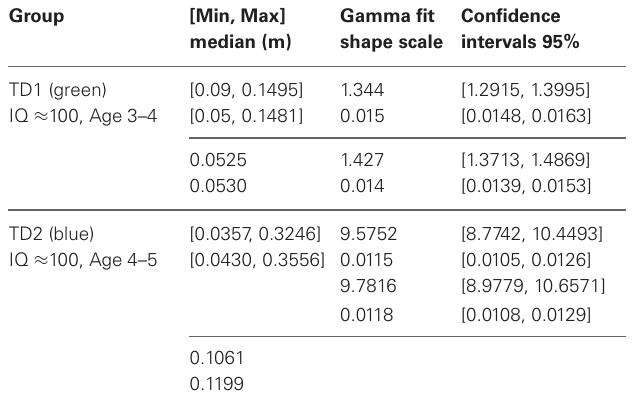
Table A4 | Population Gamma estimated values and 95% confidence intervals for each group across all trials for the time-normalized path